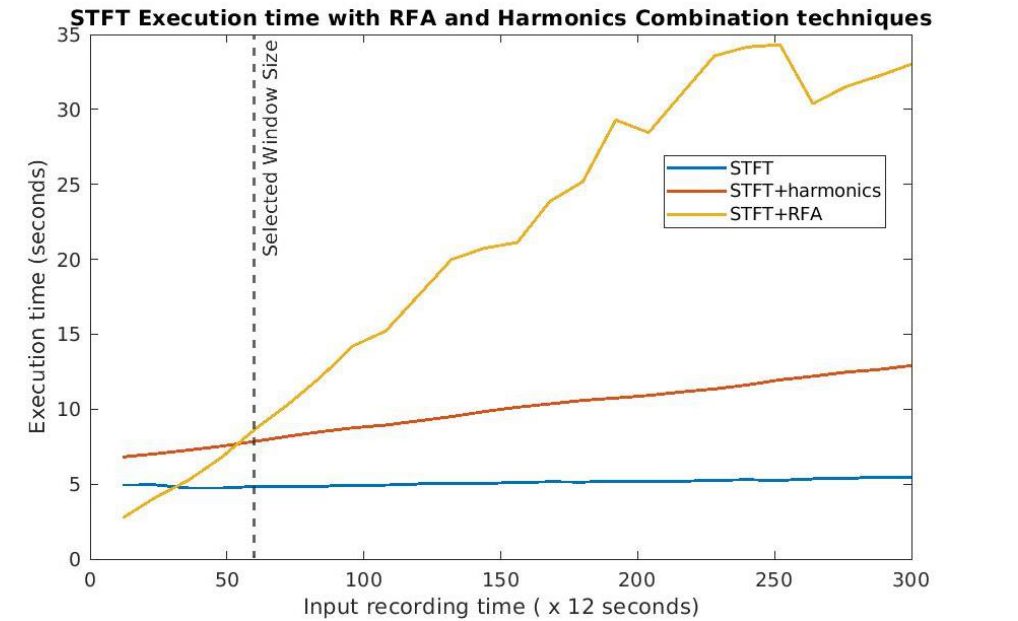
Figure 10. Execution time of the STFT algorithm in combination with ENF enhancement